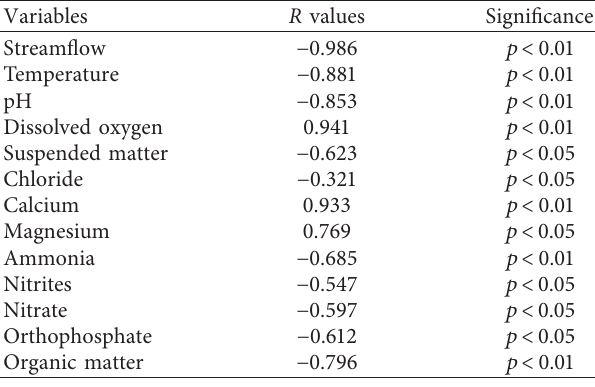
Table 5: Spearman’s correlations between crab abundance and environmental variables.